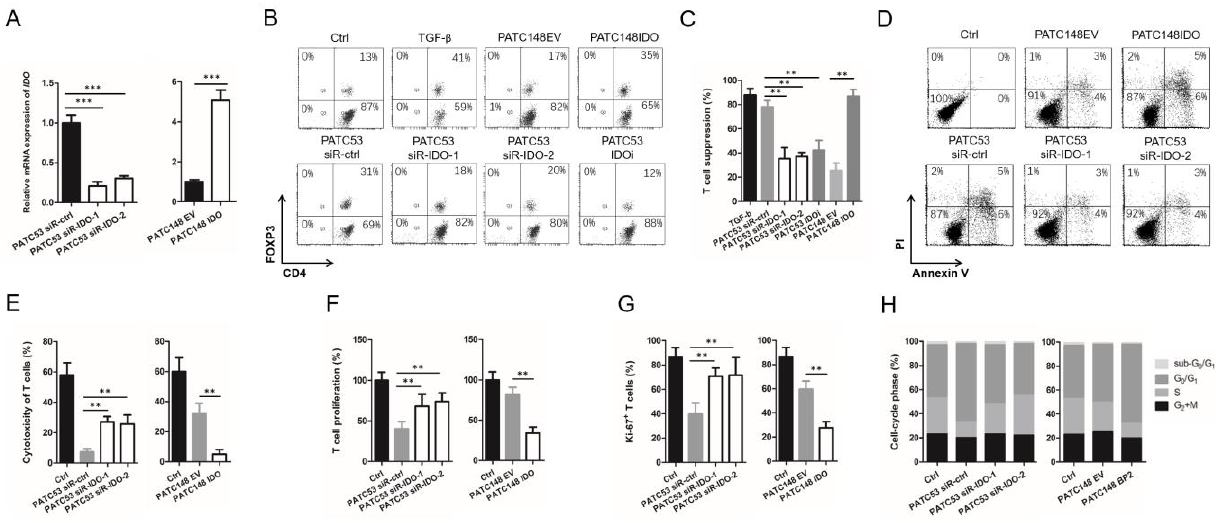
Figure 5. IGFBP2 alters T cell differentiation by inducing IDO expression in human PDAC. ( A ) Relative IDO mRNA expression levels of different PDAC cell lines were assessed by qRT-PCR, normalized to GAPDH (*** p < 0.001 by ANOVA for PATC53 or the Student’s t -test for PTAC148). ( B ) Flow cytometry analysis of human CD4 + T cells cultured without or with TGF- β or co-cultured with PDAC cell lines differentially expressing IDO for CD4 + FOXP3 + Tregs. ( C ) Activated CD8 + T cells were co-cultured with the Tregs inducted by TGF- β or PDAC cell lines to verify their T cell suppressive function (** p < 0.01 by ANOVA for PATC53 or the Student’s t -test for PTAC148). ( D ) Human CD8 + T cells co-cultured with PDAC cell lines differentially expressing IDO were assessed flow-cytometrically for apoptotic CD8 + T cells. ( E – H ) Cytotoxicity, proliferation, Ki-67, and cell cycle analysis was performed on the same CD8 + T cells as in ( D ) (** p < 0.01 by ANOVA for PATC53 or the Student’s t -test for PTAC148). Data are mean ± SD from 3 or more assays performed independently.